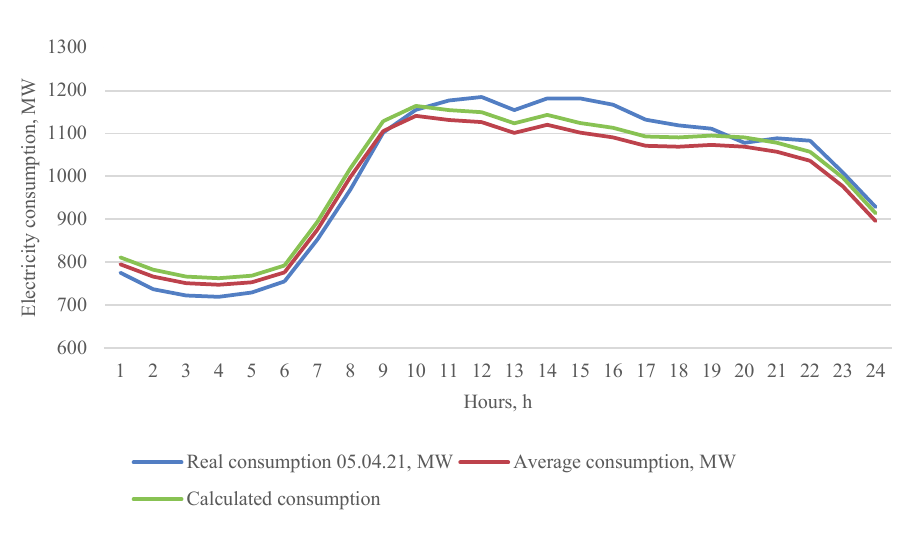
Fig. 11. Calculated electricity consumption by the weight of an hour, low